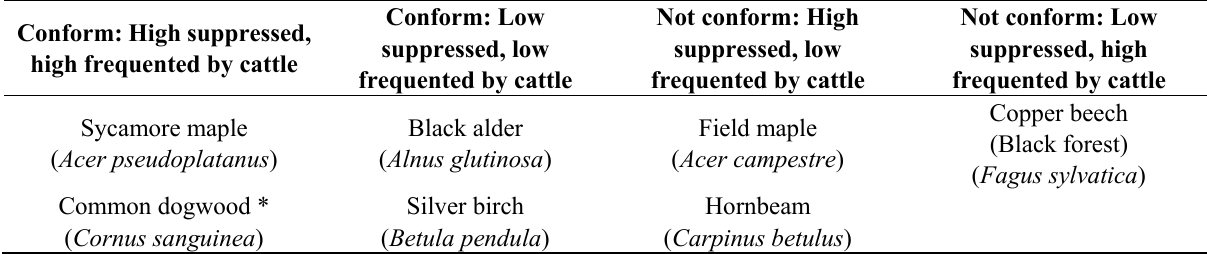
Table 4. Conformity between the structure of the groves and the preferred groves of the cattle (* preferred by cattle attested by